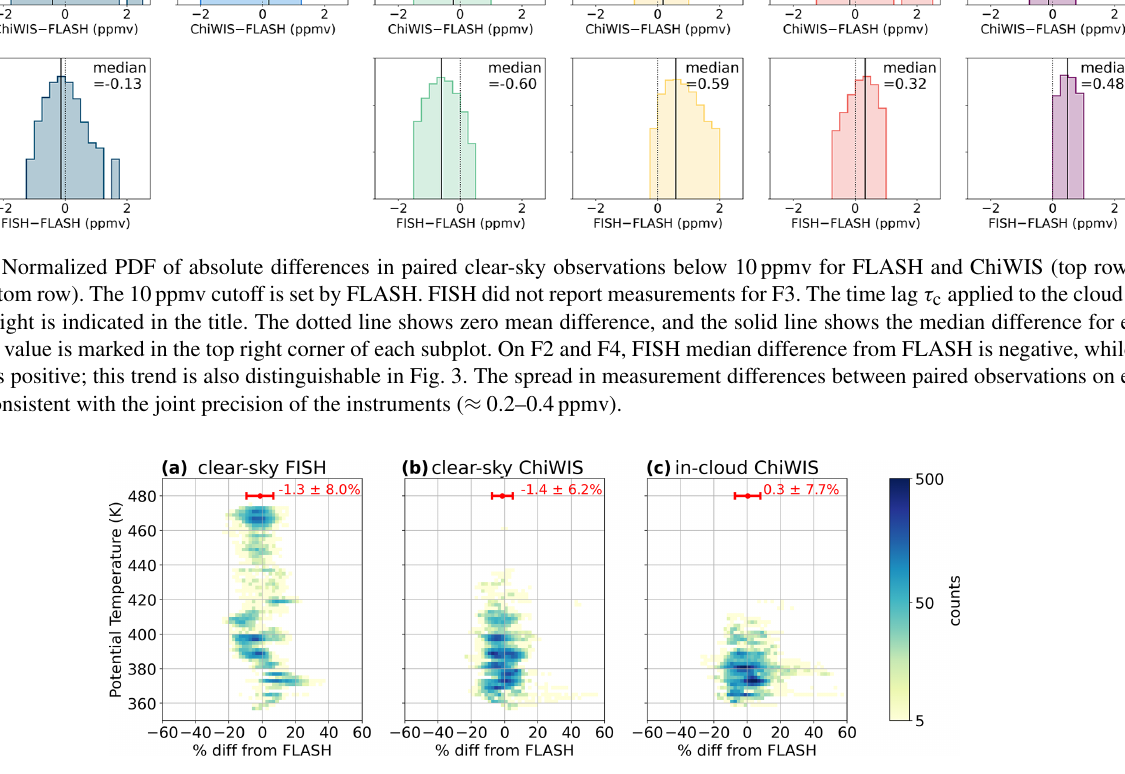
Figure 5. Histogram of percentage difference in paired H 2 O observations between instruments as a function of potential temperature for (a) clear-sky FISH, (b) clear-sky ChiWIS, and (c) in-cloud ChiWIS, all compared to FLASH. The colors show the number of observations in each 2% by 2K bin. The red error bars indicate the mean and 1 standard deviation of the percentage difference between the two instruments. Apparent altitude-dependent structure in FISH vs. FLASH may relate to flight-to-flight differences. Positive deviations in ChiWIS in cloudy conditions around 380 K are related to extreme ice concentrations in fresh anvil outflow on